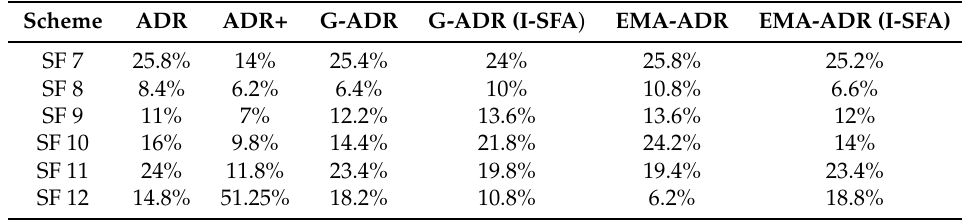
Table 3. Final SF assignment percentage of static EDs (with starting SF = 12, N = 500, uplink period = 24 packets/day, and total simulation time = 4